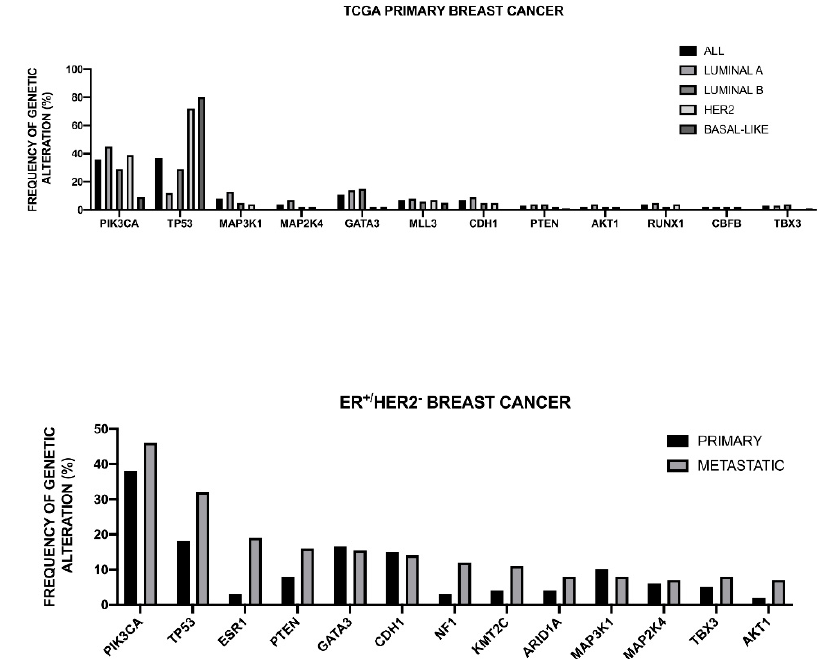
Figure 1. Genomic landscape of recurrent genetic alterations of breast cancer. Top Panel: recurrent genetic alterations in primary breast cancers subdivided according to intrinsic subtype. The data shown in the Figure are reported bt TCGA [46]. Bottom Panel: Most recurrent somatic mutations observed in primary and metastatic ER + / HER2 - breast cancers. The data shown in the Figure are reported by Angus et al. [47].